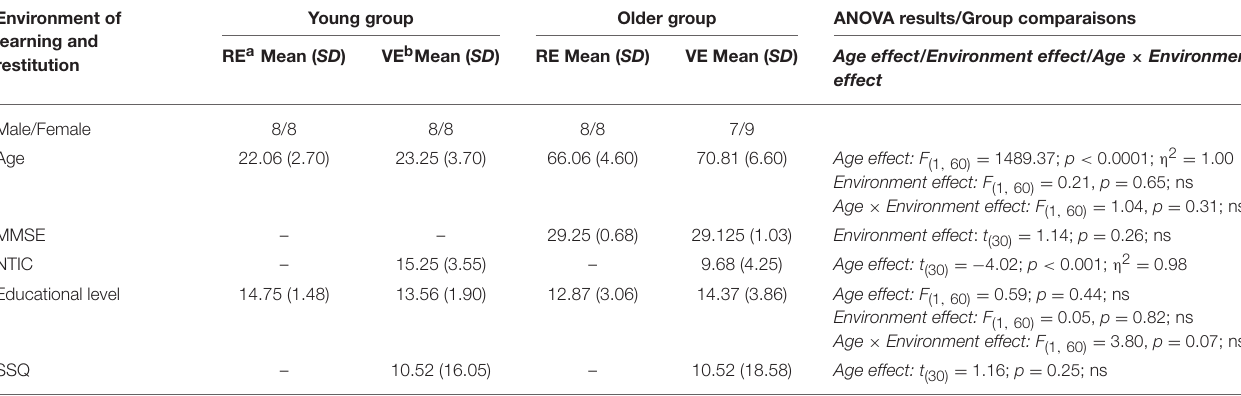
TABLE 1 | Demographic characteristics of the participants. Environment of Young group Older group ANOVA results/Group learning and restitution